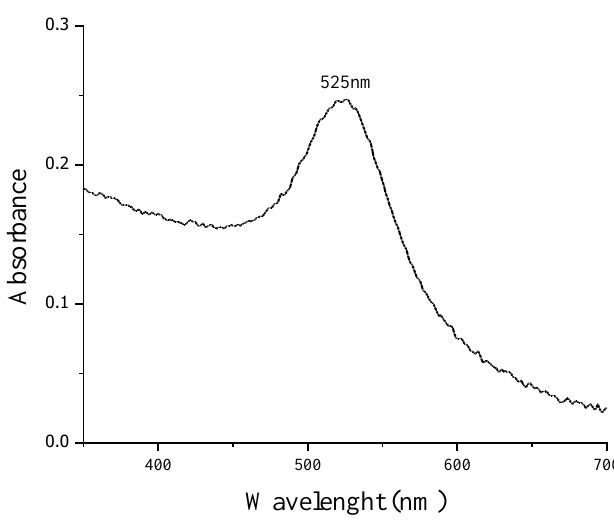
Figure 3. XRD pattern of AuNPs.